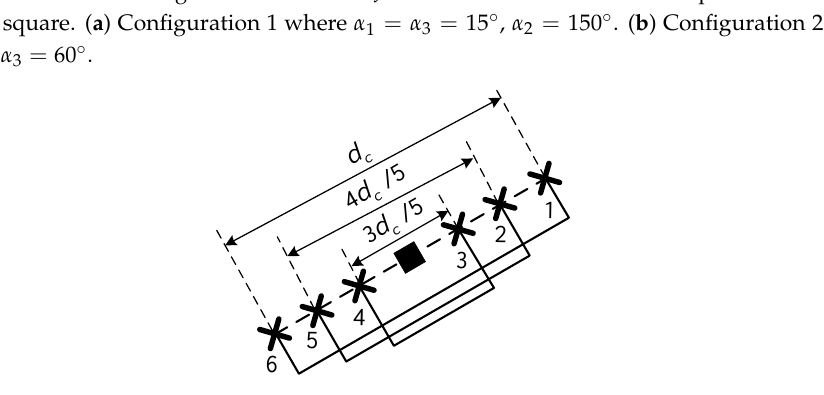
Figure 7. Configuration of L-MRCJ with six antenna elements. The base-lengths of the three jammer loops are d c , 4 d c /5 and 3 d c /5,